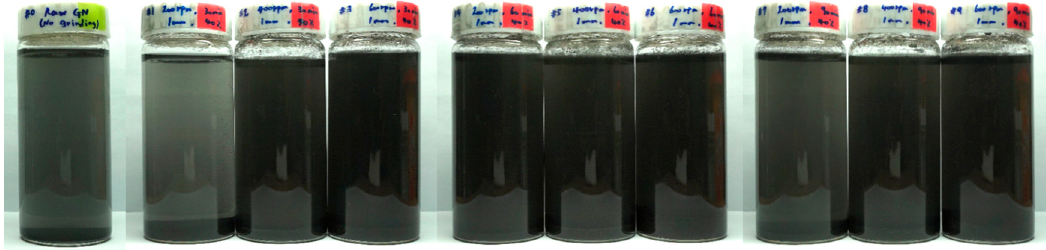
Figure 7. Dispersion result of GN nanofluid during 15 days.